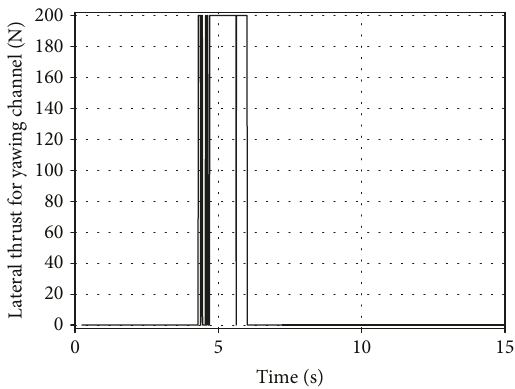
Figure 9: Variation of lateral thrust P